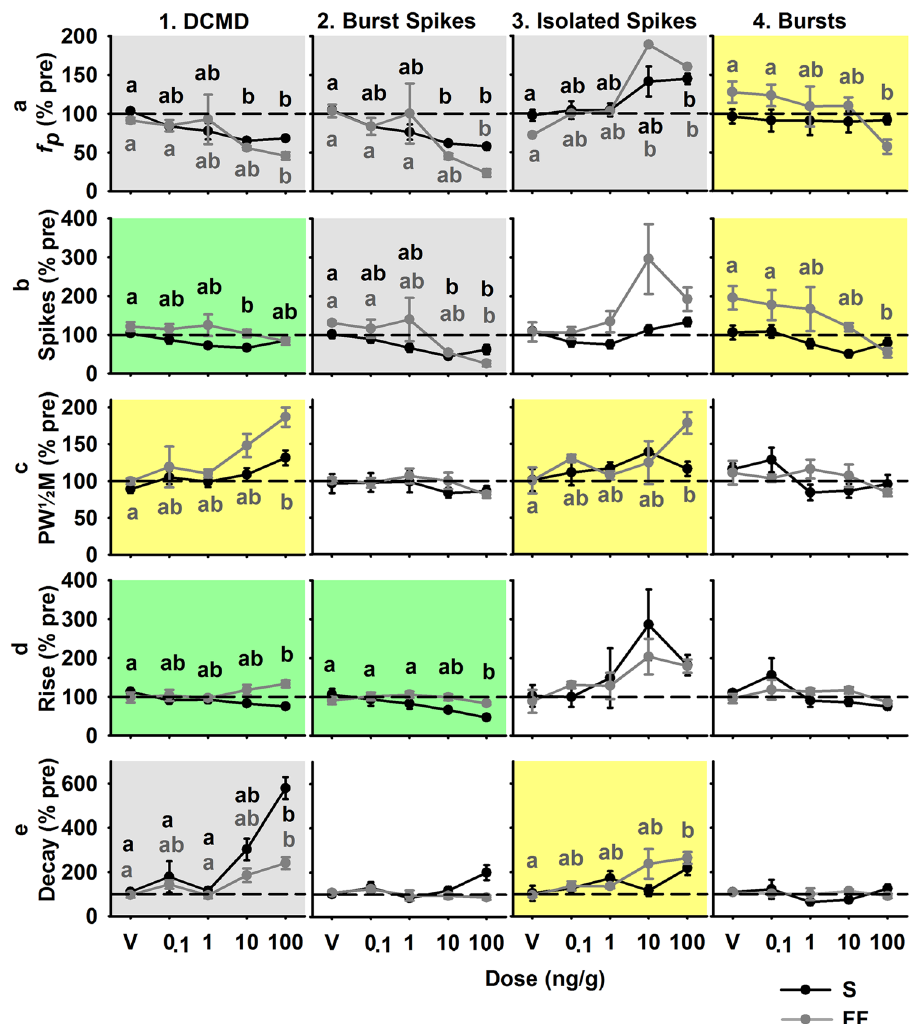
Figure 5. Response parameters (mean ± SEM) of the four DCMD rates (full DCMD, burst spikes, isolated spikes, and bursts) at 110 (S background) and 120 minutes (FF background) after treatment with an IMD dose (ng/g) or the vehicle (V). Data plotted as a percent of pre-treatment values within each animal. Grey backgrounds indicate a significant effect of one or more IMD dose for stimuli presented over both S and FF backgrounds, yellow indicates a significant effect within FF background only, and green for S background only. Significant results of post hoc analyses are indicated with letters colour coded to the respective background